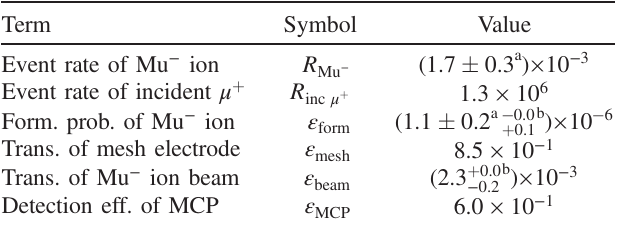
TABLE I. Summary oftheevaluationofthe Mu −